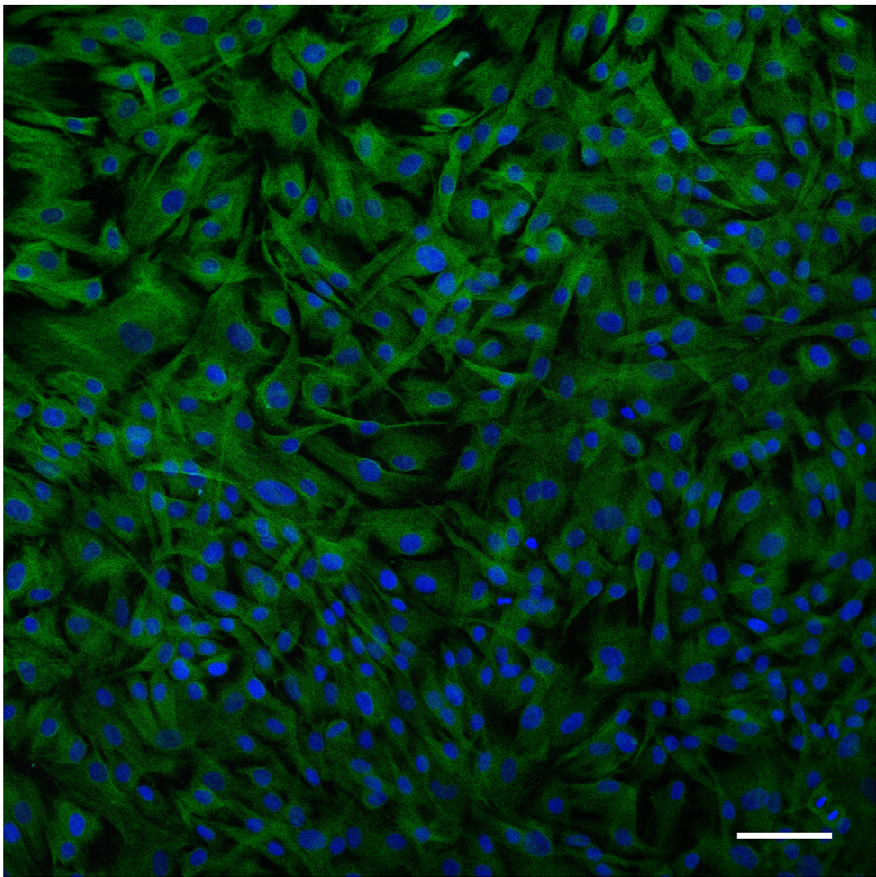
Figure 1. Confocal image of pterygium cells in culture stained with antibodies against vimentin (green), CD31 (white), and keratin 4 (red). DAPI was used as a nuclear counterstain (blue). All cells were vimentin-positive and no immunoreactivity was found for markers of epithelial or endothelial lineages. Bar=20 m m.